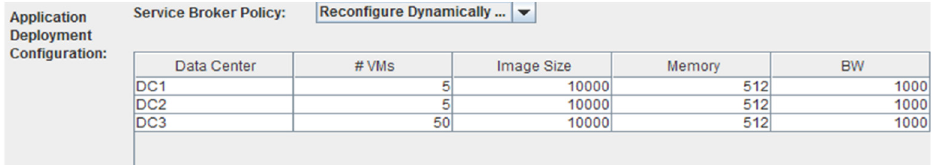
Figure 10. The application deployment configuration of Data Centers 1 to 3 based on reconfiguring dynamically with load SBP.